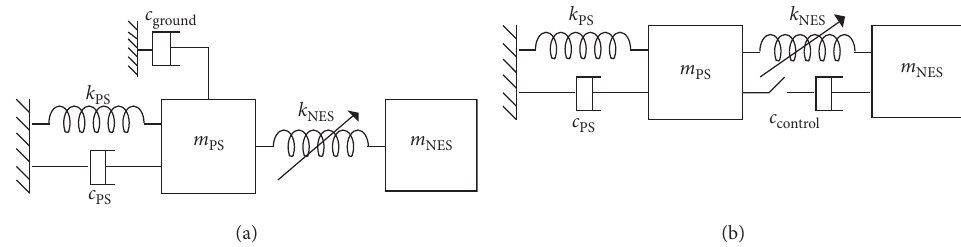
Figure 2: (a) Ideal damping model. (b) Equivalent damping